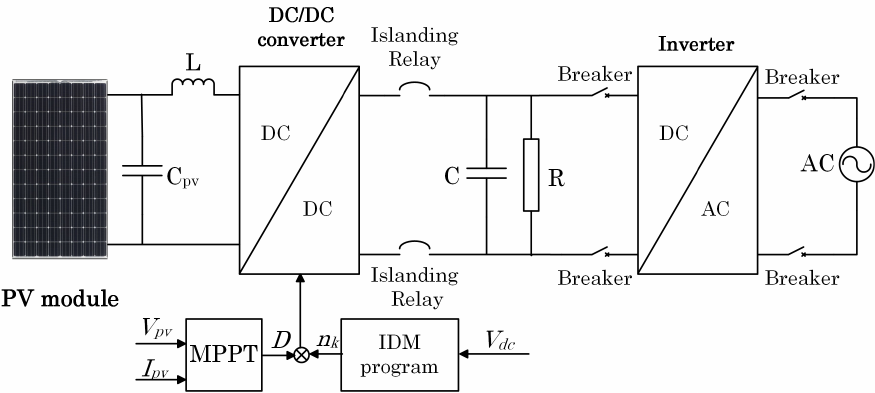
Figure 4. System model under analysis.